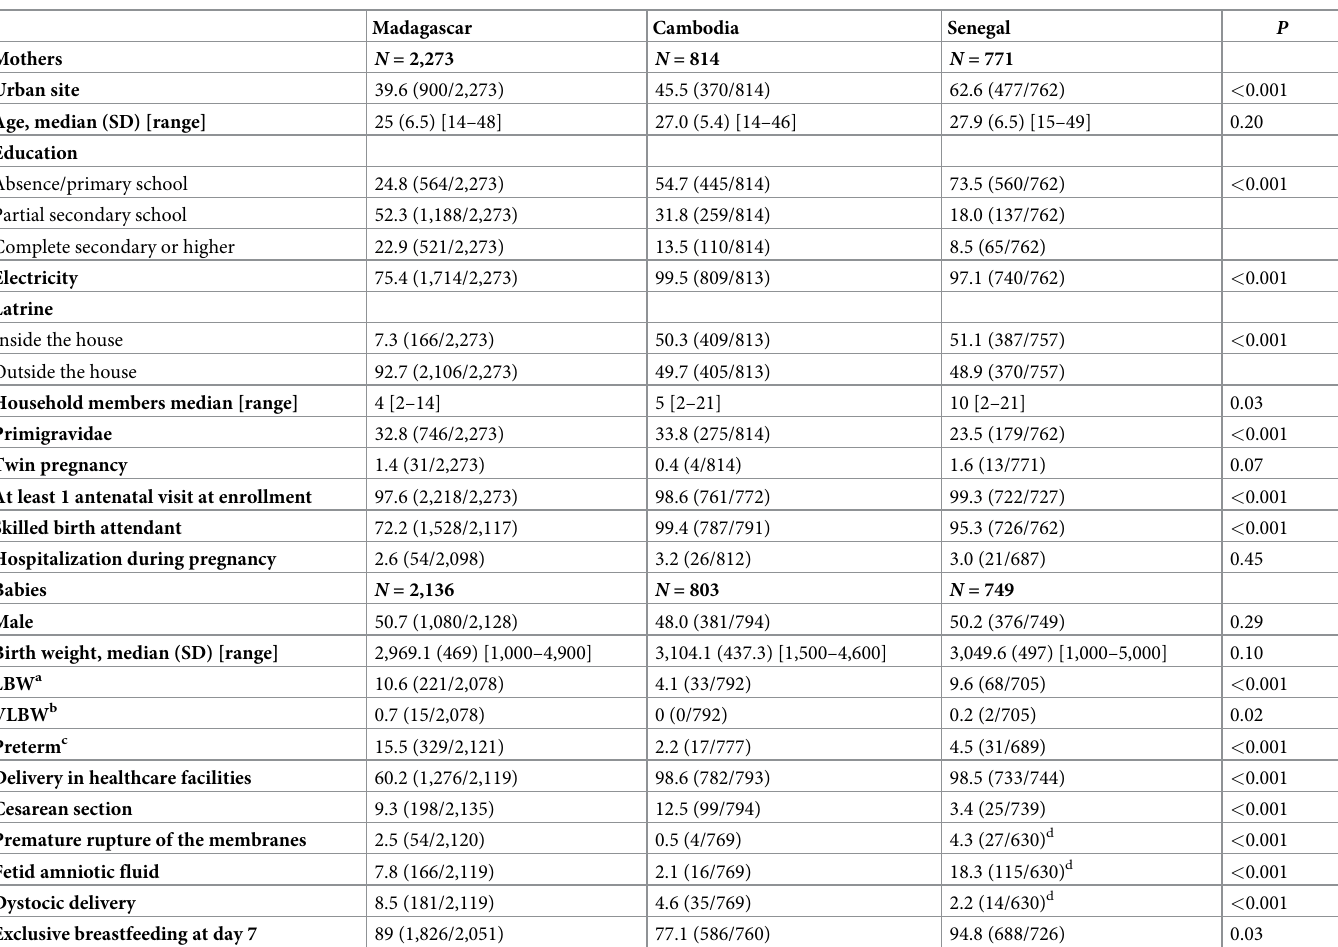
Table 1. Characteristics of the mothers and their